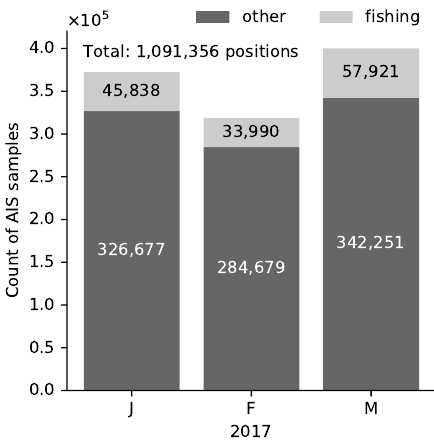
Figure 3. Monthly count of AIS samples for fishing and non-fishing (other) vessels.